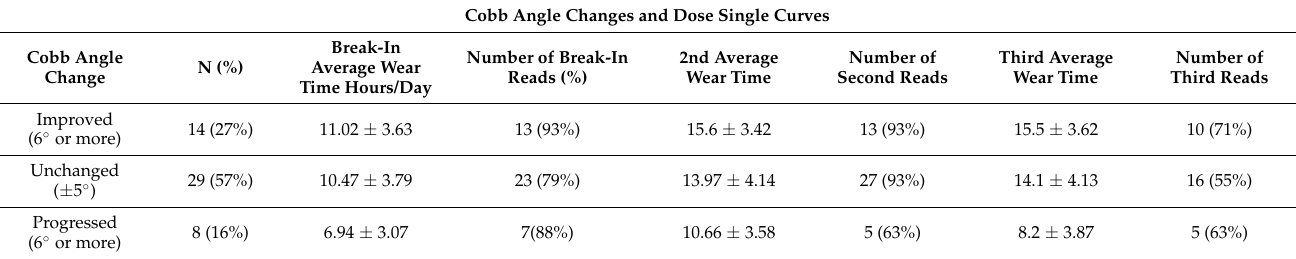
Table 3. Cobb angle changes and doses for single curves.